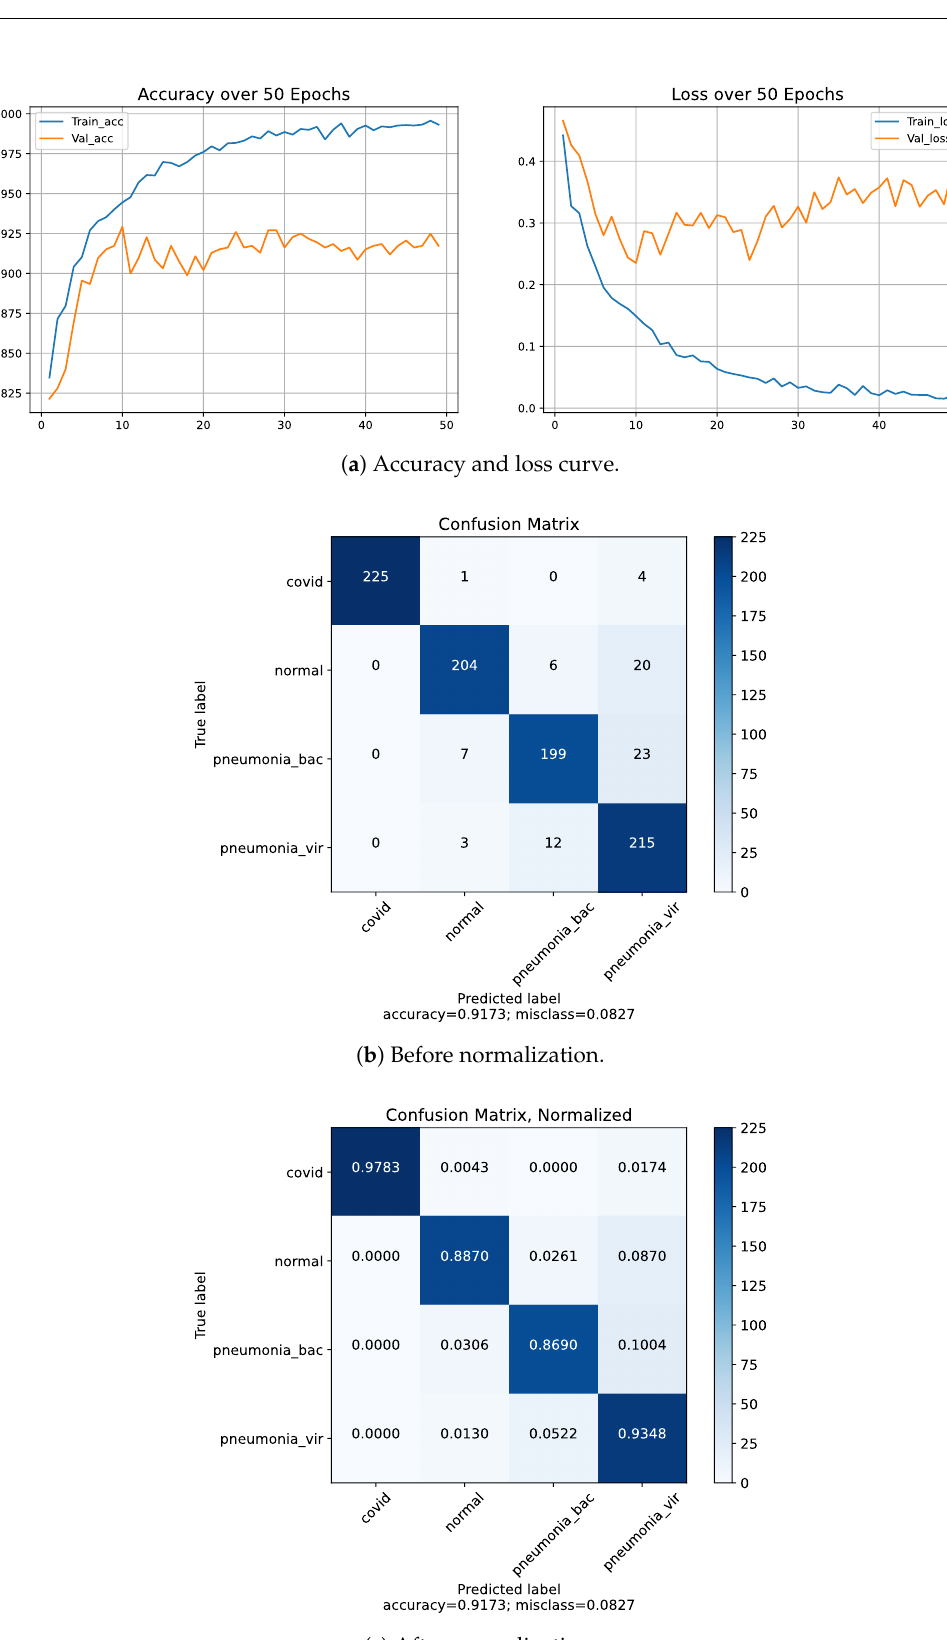
Figure 9. Results of Dataset-1, fold-4 for 4-class COVID-19/normal/bacterial pneumonia/viral